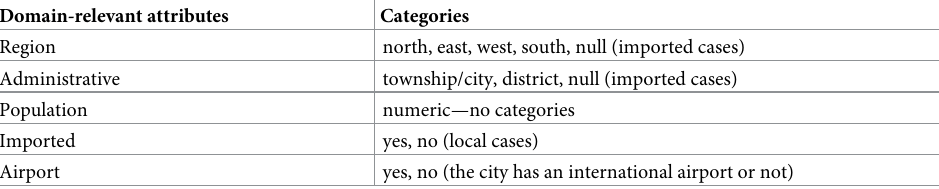
Table 1. Domain-relevant attribute categories used in Taiwan COVID-19 confirmed infection cases.